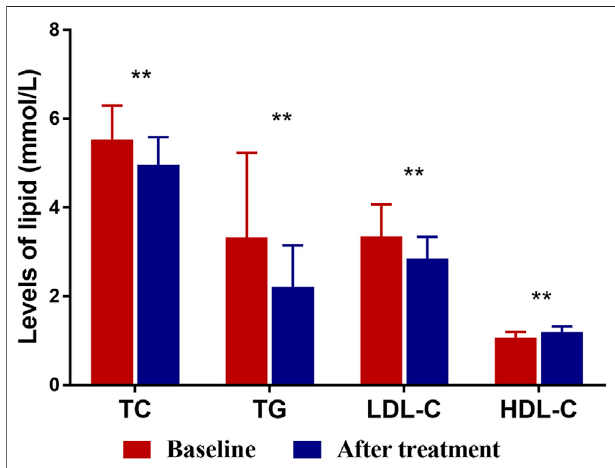
FIGURE1| ThelevelsofTC,TG,LDL-CandHDL-Catbaselineandafter XZK treatment. After XZK treatment, the levels of TG, TC and LDL-C decreased signi fi cantly, while the levels ofHDL-C increased signi fi cantly (** p < 0.01). Horizontal lines represent standard deviation.